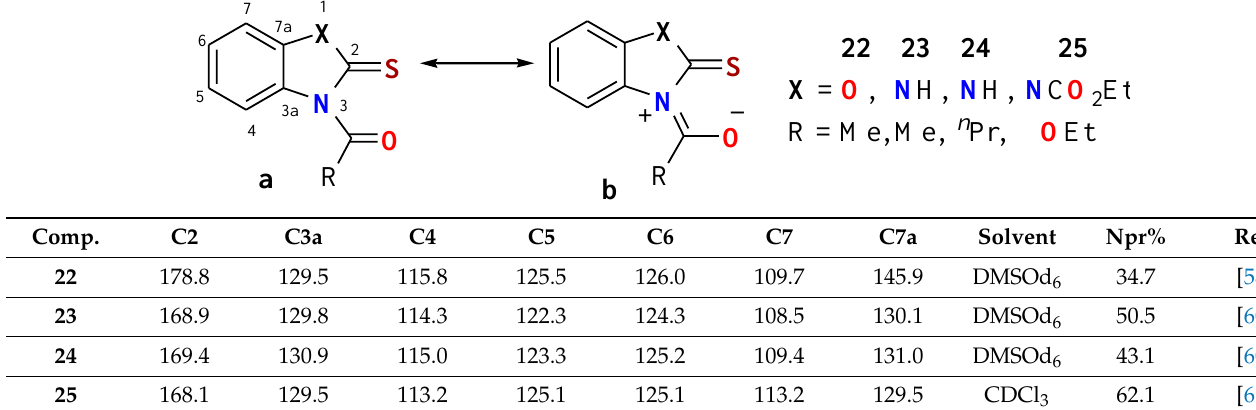
Table 8. N1-acylbenzoheterazolidine-2-thiones 22 .